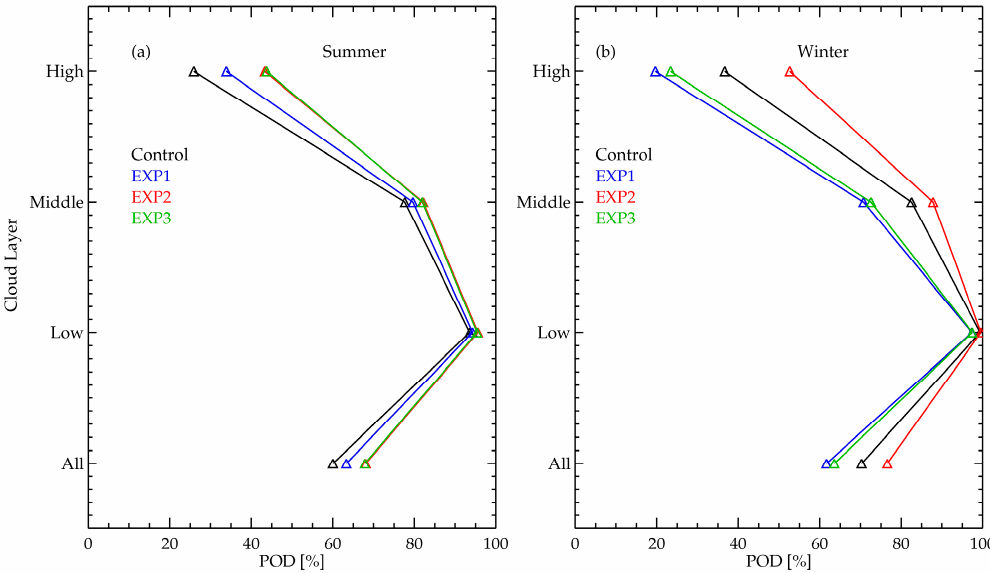
Figure 7. The POD values of the four experimental datasets: Control (black), EXP1 (blue), EXP2 (red), and EXP3 (green), for ( a ) summer and ( b ) winter based on MPL validation.